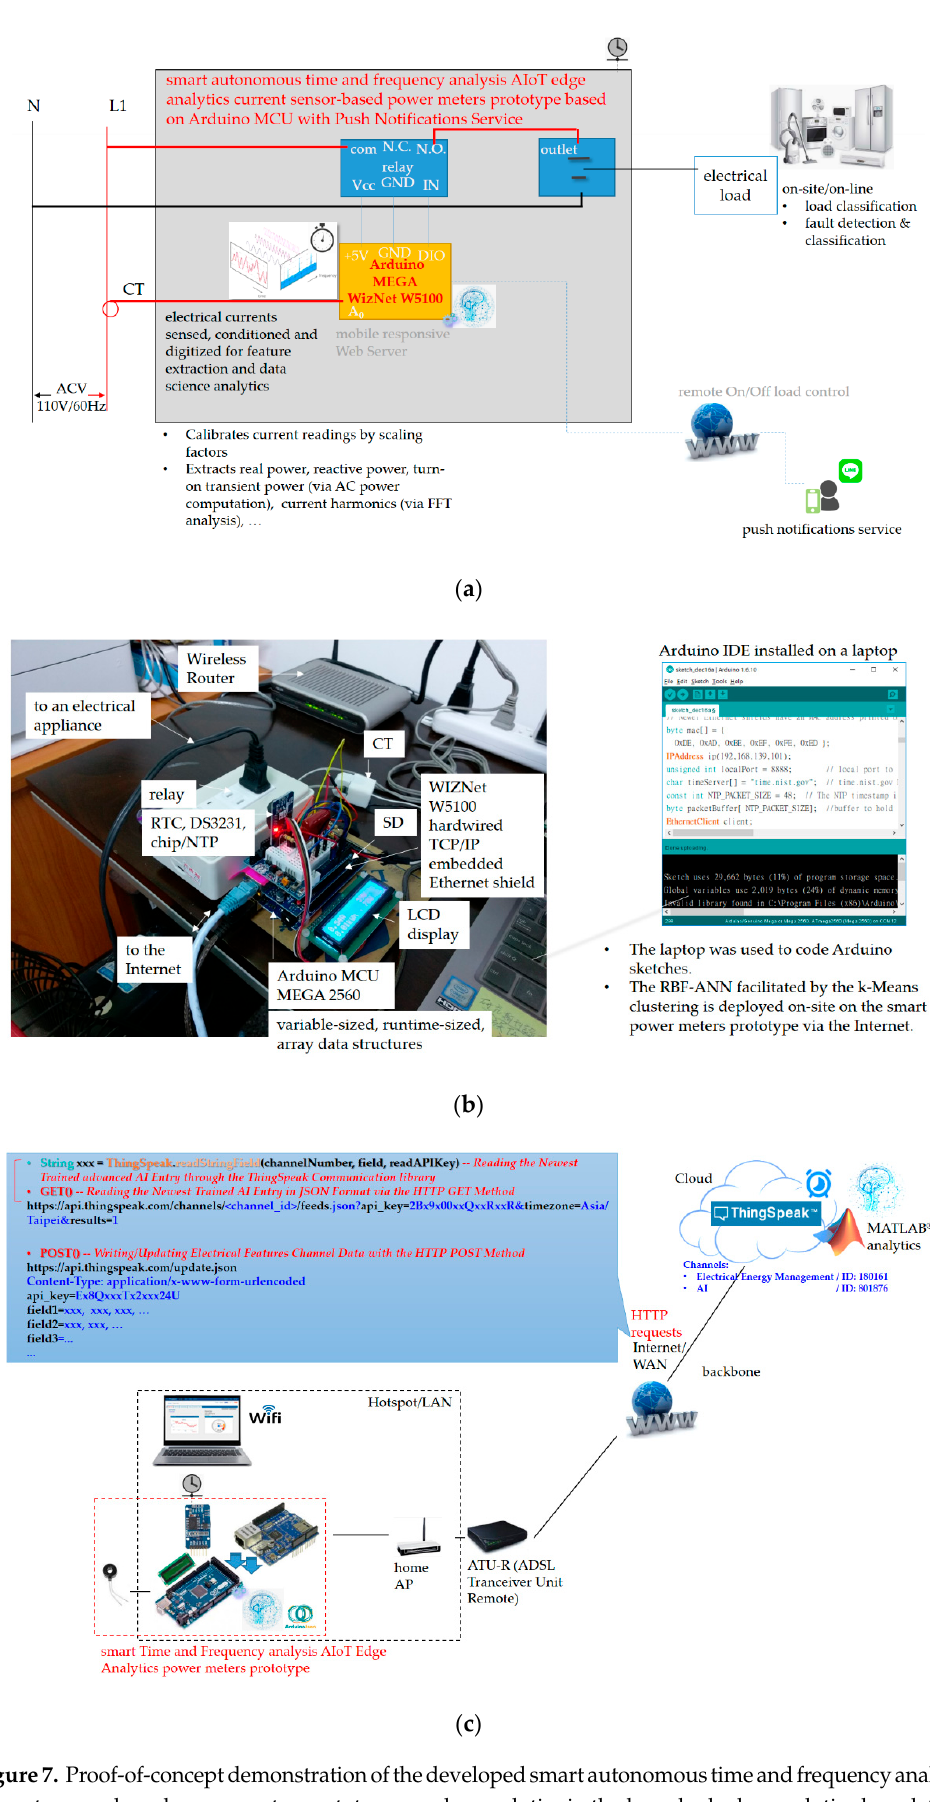
Figure7. Proof-of-conceptdemonstrationofthedevelopedsmartautonomoustimeandfrequencyanalysis current sensor-based power meter prototype as edge analytics in the launched edge analytics-based